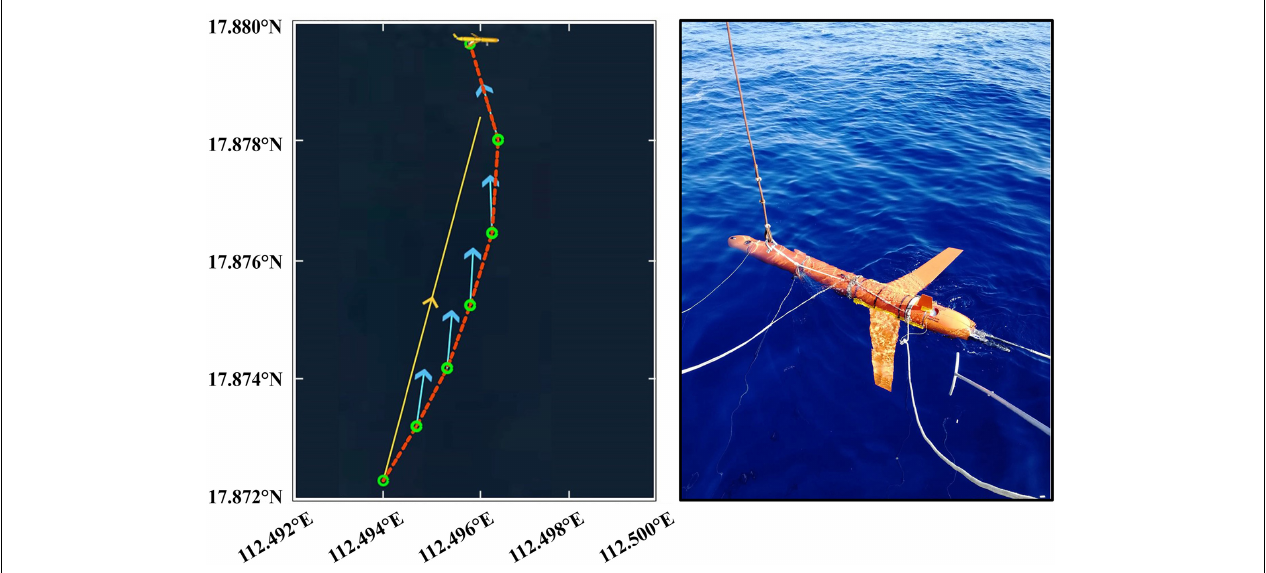
FIGURE 3 | Left shows the glider trajectory in the field experiment and right shows the glider used in this experiment. The solid yellow line is the planned route, the dotted red line is the actual trajectory, the green circles represent the location of each surface point, and the blue arrows are the heading angles calculated by the